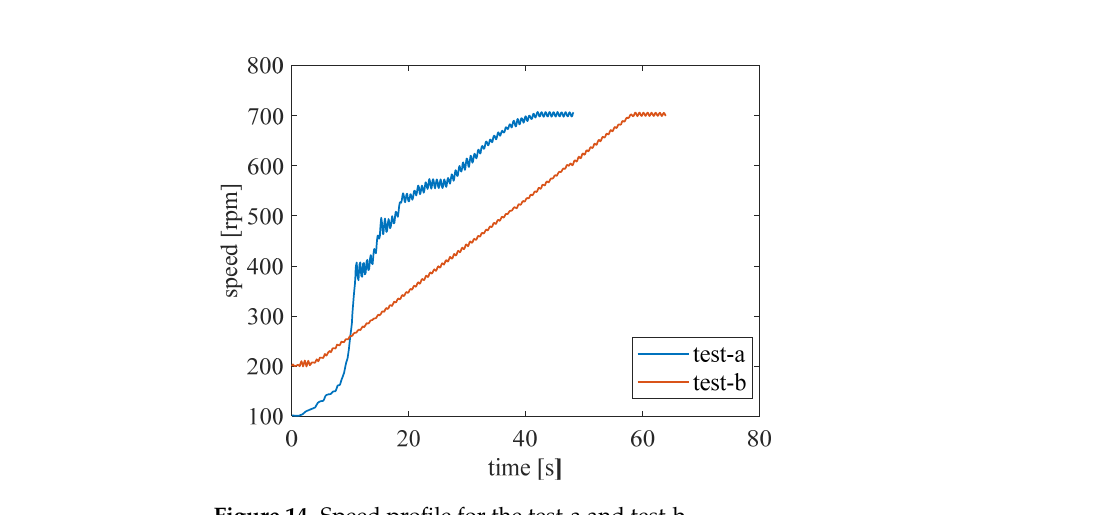
Figure 14. Speed profile for the test-a and test-b.